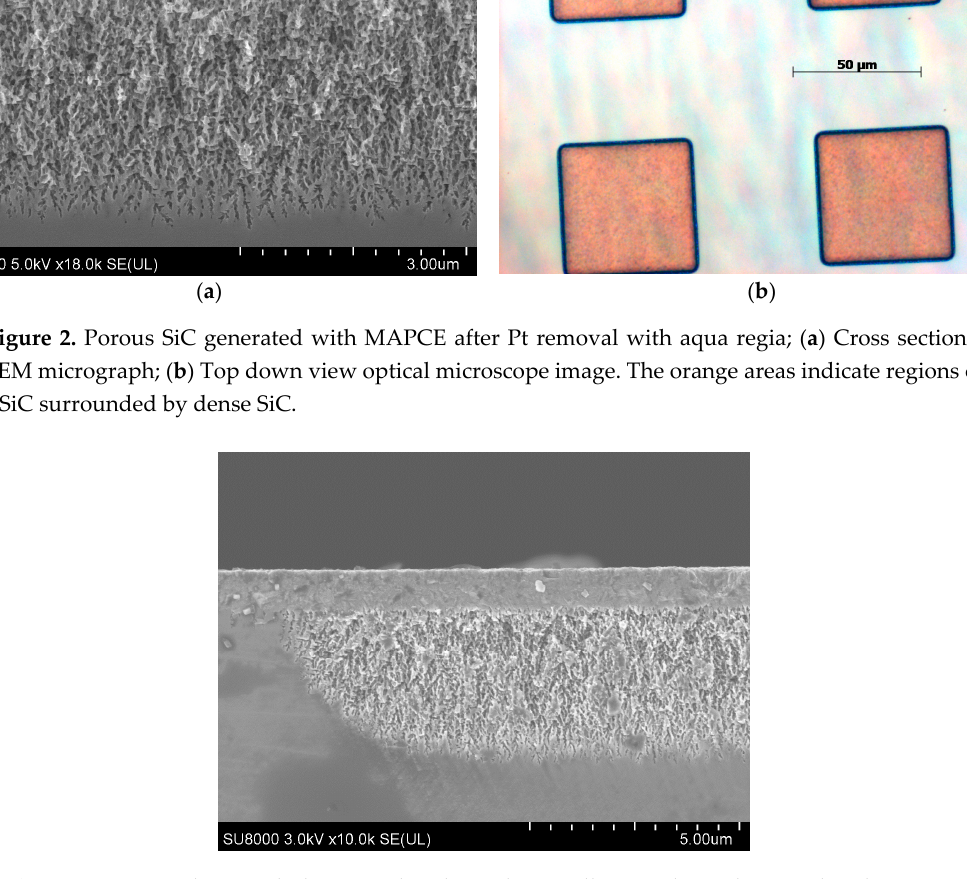
Figure 3. Porous silicon carbide covered with a polycrystalline SiC layer deposited with